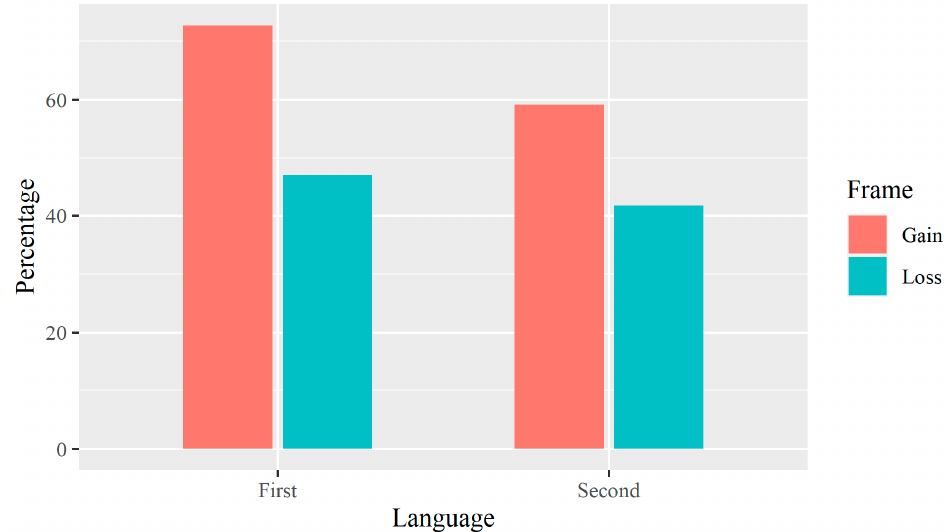
Figure 2. Combined percentage of safe (“A”) responses for the Asian disease and Financial crisis problems in the first and second language.